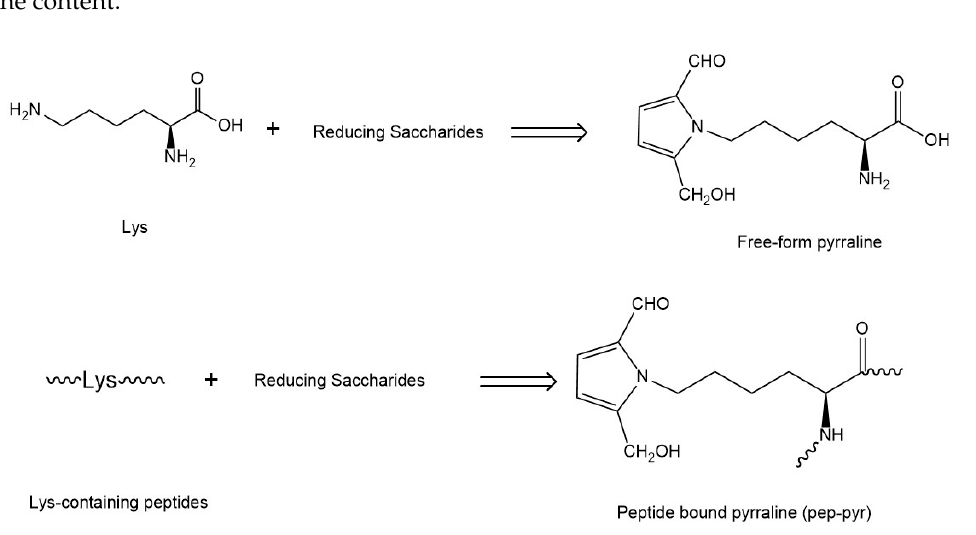
Figure 2. Free form and peptide bound pyrraline formation derived from Lys and peptides, individually.